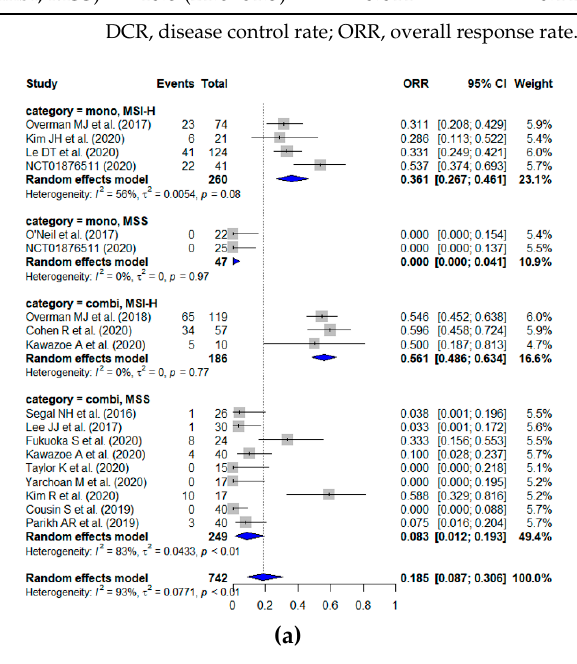
(b) Figure 5. Forest plots of the ( a ) pooled ORR and ( b ) DCR of each subgroup according to the microsatellite phenotype and drug regimen in patients treated with ICIs as second ‐ or more ‐ line therapy. 4. Discussion In this study, we evaluated the treatment efficacy of ICI ‐ based therapy for patients with advanced/metastatic CRC using the data from 30 clincial trials. The findings of this meta ‐ analysis indicate that the microsatellite phenotype of tumor and drug regimen significantly influence the treatment response of patients with advanced/metastatic CRC administered ICI. In MSS/pMMR tumors, a durable response was noted in the second ‐ or more ‐ line treatment when ICI was administered as part of a combination treatment. We used ORR and DCR as the primary endpoints of our analysis. Although survival time such as overall survival has been regarded as the most reliable metric for assessing the efficacy of anticancer treatment, overall survival has several drawbacks when used a primary endpoint in clinical trials; the sample size needs to large enough, a much longer